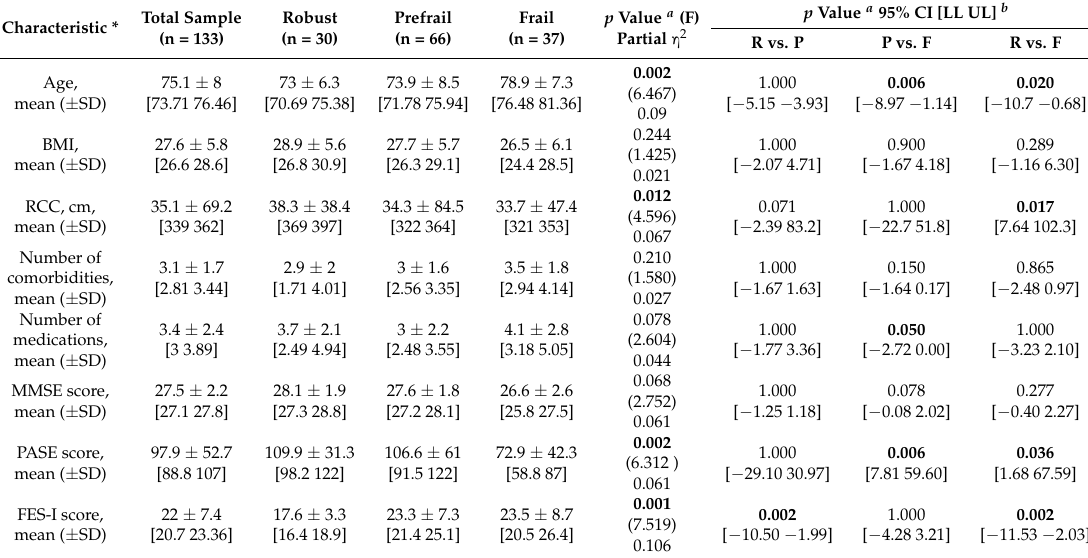
Table 1. Demographic and clinical characteristics.